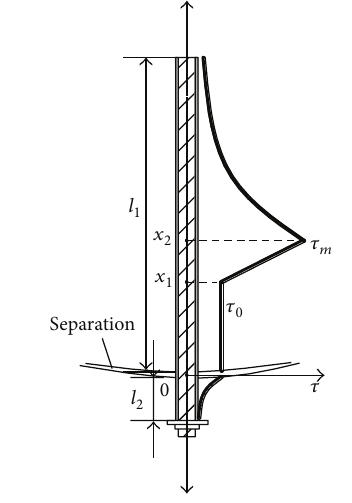
Figure 8: Relationship of the bolt support strength versus strata separation width and the bolt support strength versus decoupling length (the separation is located in the middle).